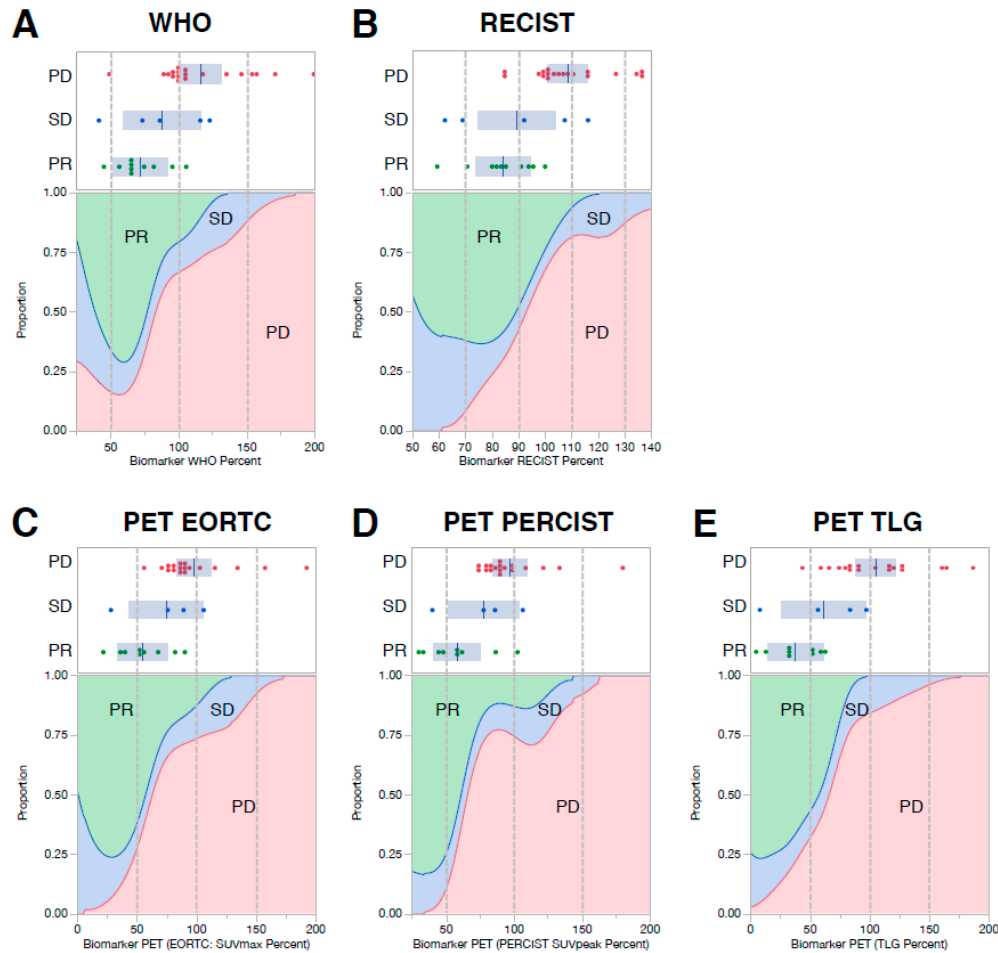
Figure 2. CT and PET imaging (obtained between 7–14 days following treatment with IGF-1R Abs +/ − mTOR inhibitor) are predictive of each patient’s best clinical response. CT measures of response included WHO and RECIST criteria (Panels A and B , respectively). PET measures of clinical response included EORTC (Panel C ), PERCIST (Panel D ), and TLG (Panel E ). Dot plots and density plots are shown for each measurement parameter. The dot plots indicate each patient’s percent response compared to the pre-treatment baseline tumor measurements, color-coded by their clinical response; progressive disease (PD; red), stable disease (SD; blue), and partial response (PR; green). The density plots beneath each dot plot show the relative probability distributions of achieving a partial response (green), stable disease (blue), or progression (red) across the entire spectrum of CT or PET responses represented by the data set. No patient achieved a complete response. Table 2. Imaging-based measures of response predict tumor response and clinical benefit. *Receiver operating characteristics (ROC) of CT and PET imaging are shown.